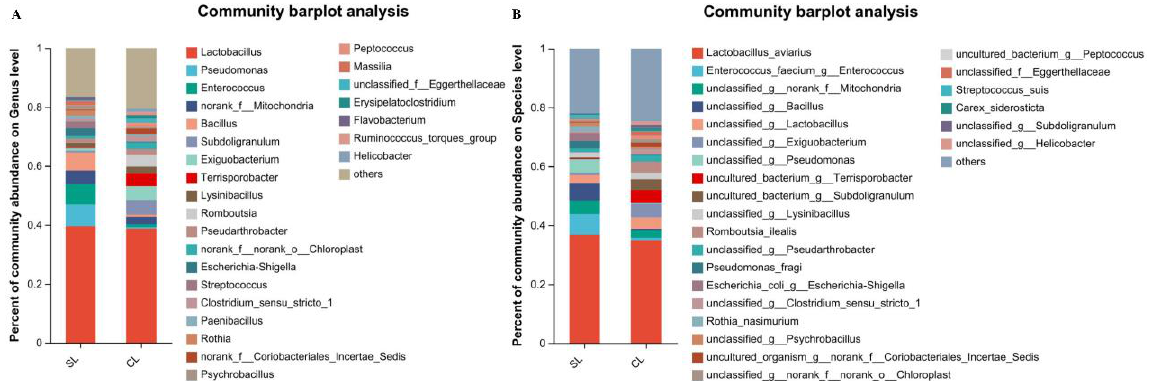
6 of 12 Figure 2. ( A ) represents the composition of intestinal microbiota of Anser fabalis at the phylum level; ( B ) shows the Venn diagram of intestinal microbiota in Anser fabalis at the genus level. Lactobacillus was the main genus in both SL and CL A. fabalis , with a relative abun- dance of 39.54% and 38.69%, respectively. In SL A. fabalis , the relative abundance of Pseu- domonas was 7.34%, that of Enterococcus was 6.99%, and that of Bacillus was 6.09%. In CL A. fabalis , the relative abundance of Subdoligranulum was 5.02%, that of Exiguobacterium